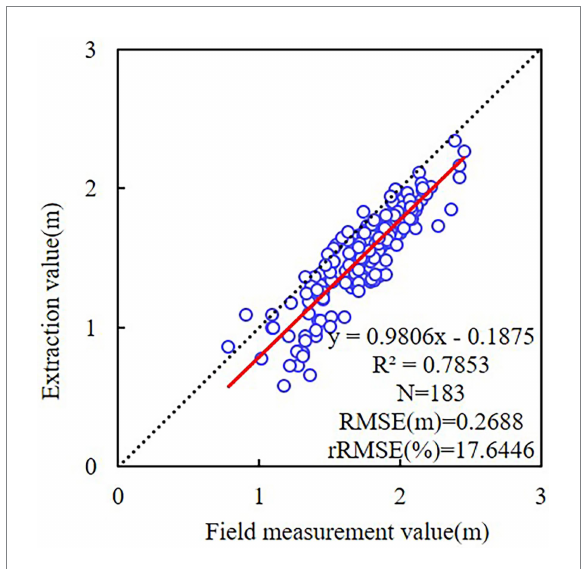
FIGURE 8 Linear regressions of tree height between the field measurement and different ResU-Net